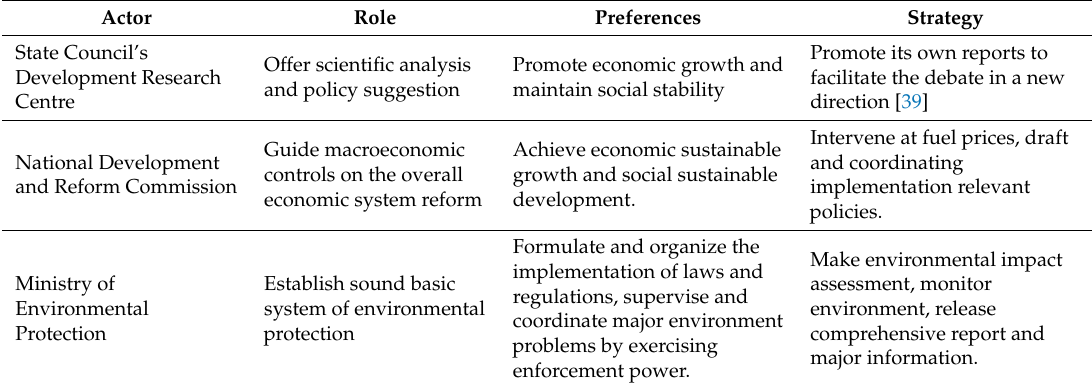
Table 3. The most influential policy actors in central government.